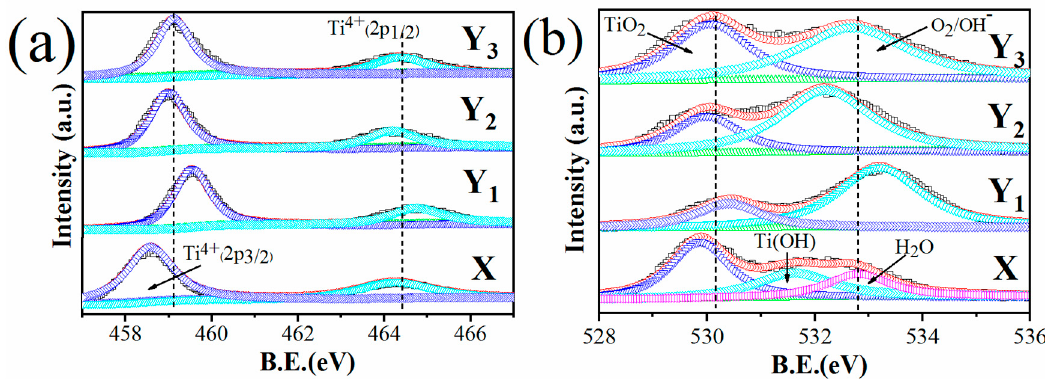
Figure 4. High resolution XPS spectra for groups X, Y 1 , Y 2 and Y 3 ( a ) Ti2p ( b ) O1s.